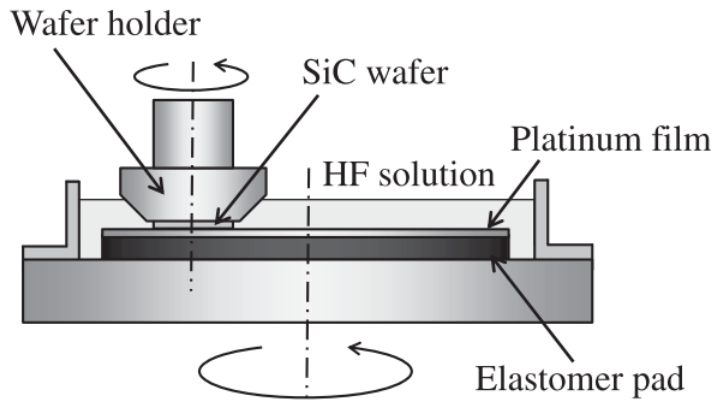
Figure 26. Schematic of CARE system for single-crystal SiC [58].